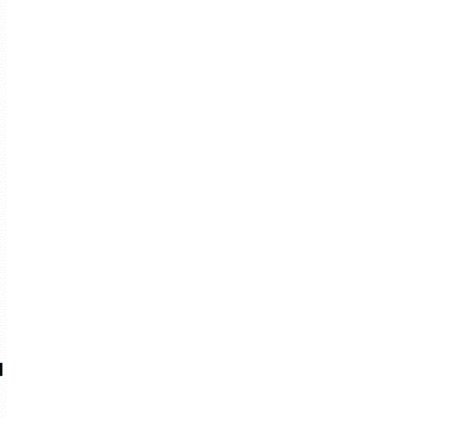
Figure 1. Timing jitter PSD of twin soliton molecule in mode-locked Ti:sapphire laser measured by BOC technique.